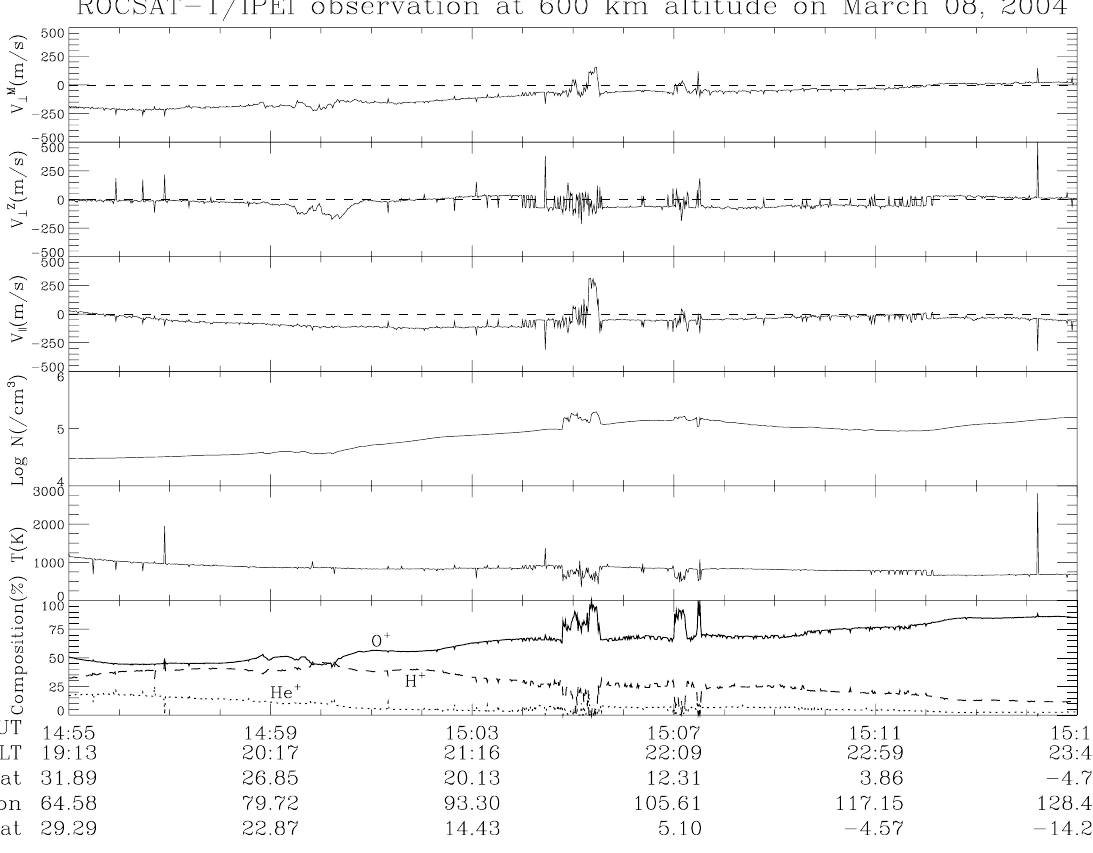
Fig. 9. Data from ROCSAT-1 at altitude 600km on 8 March 2004: vertical (meridional) perpendicular ion velocity V M ⊥ , zonal perpendicular ion velocity V Z ⊥ , field-aligned ion velocity V k , electron density log N , and O + , H + , and He + composition plotted versus universal time, longitude and dip latitude. From Yokoyama et al.